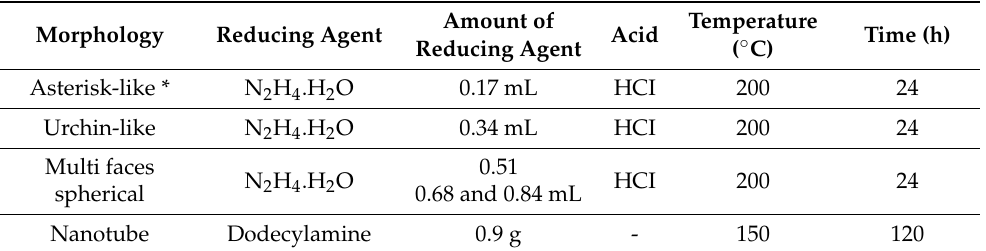
Table 1. Summary of monoclinic VO 2 morphologies and corresponding experimental synthesis